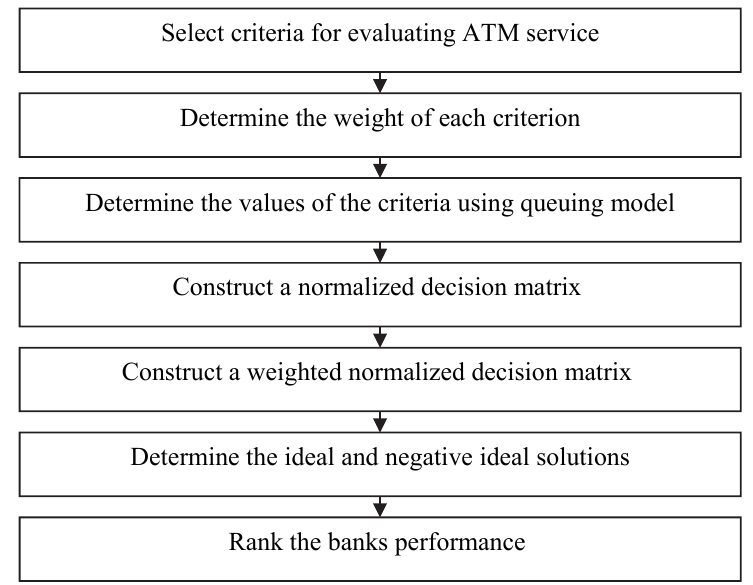
Fig. 1. Conceptual framework for bank’s ATM service ranking